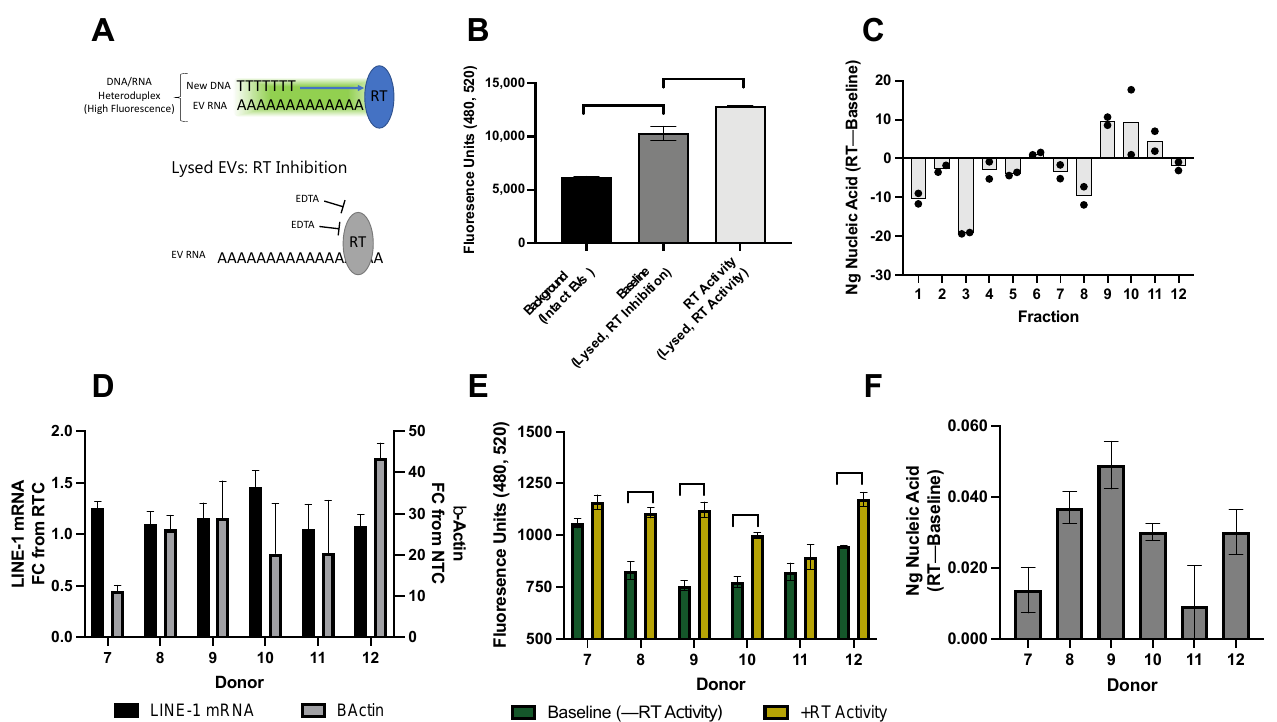
Figure 6. Reverse transcriptase activity in EVs from BaP stimulated cells and healthy plasma donors. ( A ) The modified ENZ-check reverse transcriptase (RT) activity assay indicates the presence of EV- derived reverse transcriptase (RT) and its ability to use extracellular vesicle (EV) mRNA and DNA as a template. During the reaction, any reverse transcriptase enzyme (i.e., ORF2p) will use EV mRNA and DNA to form RNA-DNA heteroduplexes, which bind PicoGreen and emit a fluorescent signal. This RT signal is normalized to baseline fluorescence emitted by EV DNA cargo, which is measured by inhibiting RT activity with EDTA. EVs were collected by ultracentrifugation. ( B ) Determination of baseline fluorescence and RT activity. Raw fluorescence of RT activity, background, and baseline conditions. “Background, Intact EVs” reaction constituents and PicoGreen are prevented from accessing EV cargo as the EV lipid membrane is still intact. “Baseline, RT Inhibition” EVs are lysed allowing PicoGreen to bind with DNA cargo but EDTA prevents RT activity. “RT Activity” EVs were lysed and conditions permissive for RT activity. One -way ANOVA: p < 0.05. ( C ) RT activity in EVs collected from BaP-treated cells. Fractions from Figure 2 were examined for RT activity and a DNA standard curve was used to quantify the amount of new nucleic acid generated in the RT reaction. To detect RT activity in individual plasma donors, EVs were isolated from 2.5 mL plasma via ultracentrifugation. Half the preparation was used for mRNA quantification and the other for RT activity measurement. The age and sex of plasma donors are shown in Figure 5D. ( D ) EV Long Interspersed Element-1 (LINE-1) mRNA and β -Actin levels. ( E ) Nucleic acid fluorescence. RT activity assay showing raw fluorescence values of baseline and RT activity conditions. p < 0.05: two- way ANOVA with Sidak’s multiple comparisons. ( F ) EV RT activity measurement in ng of nucleic acid. Mean, SD shown.